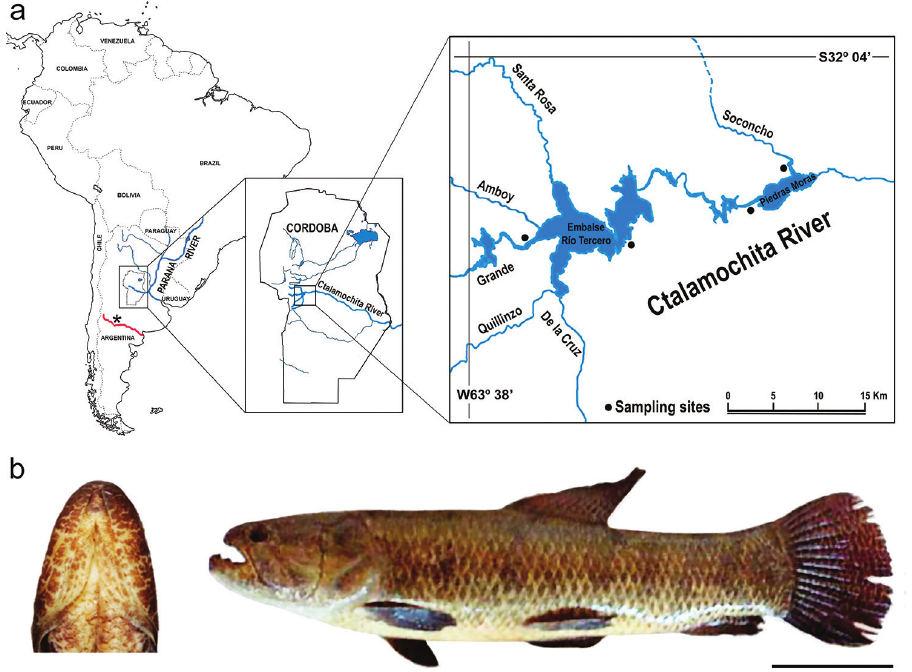
Figure 1. a Ctalamochita River location in Province of Córdoba, Argentina (left and middle images). As- terisk (*) indicate location of the Colorado River in Argentina (in red), the limit of distribution of Hoplias malabaricus and most of Neotropical fishes. Distribution of sampling sites is indicated along headwater basin (right image, black dots) b Representative specimen of Hoplias malabaricus caught in the Ctalamo- chita River and analyzed in the present study (right picture). All specimens showed the typical morpho- logical feature identifying Hoplias malabaricus , the V-shaped gular region (left picture). Bar = 10